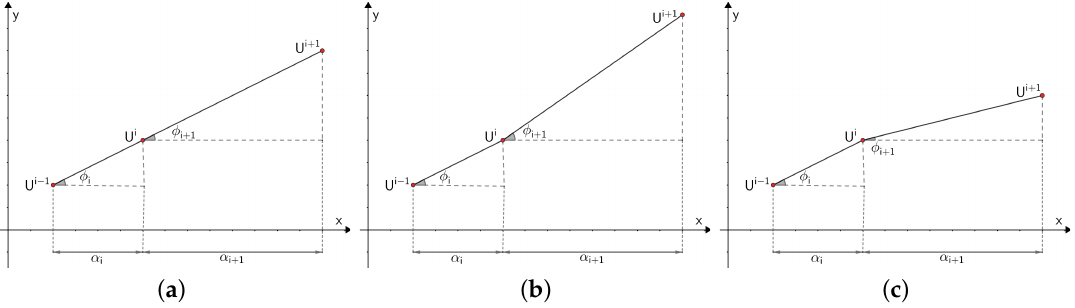
Figure 5. ( a ) The neighborhood of the vertex where L runs straight; ( b ) the neighborhood of the vertex where L has a jump up; ( c ) the neighborhood of the vertex where L has a jump